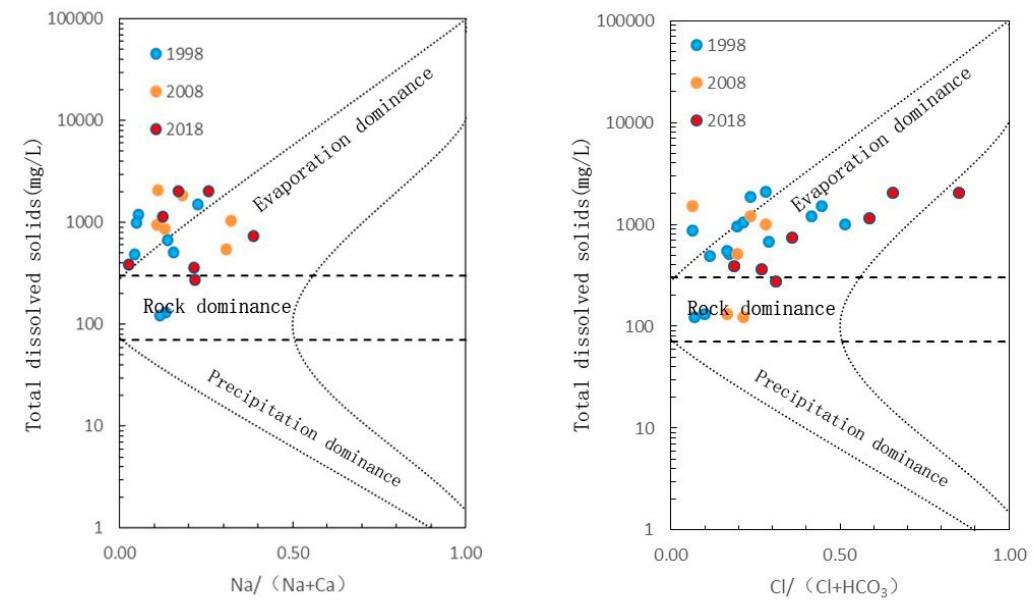
Figure 3. Representative Gibbs diagram for annual groundwater quality.